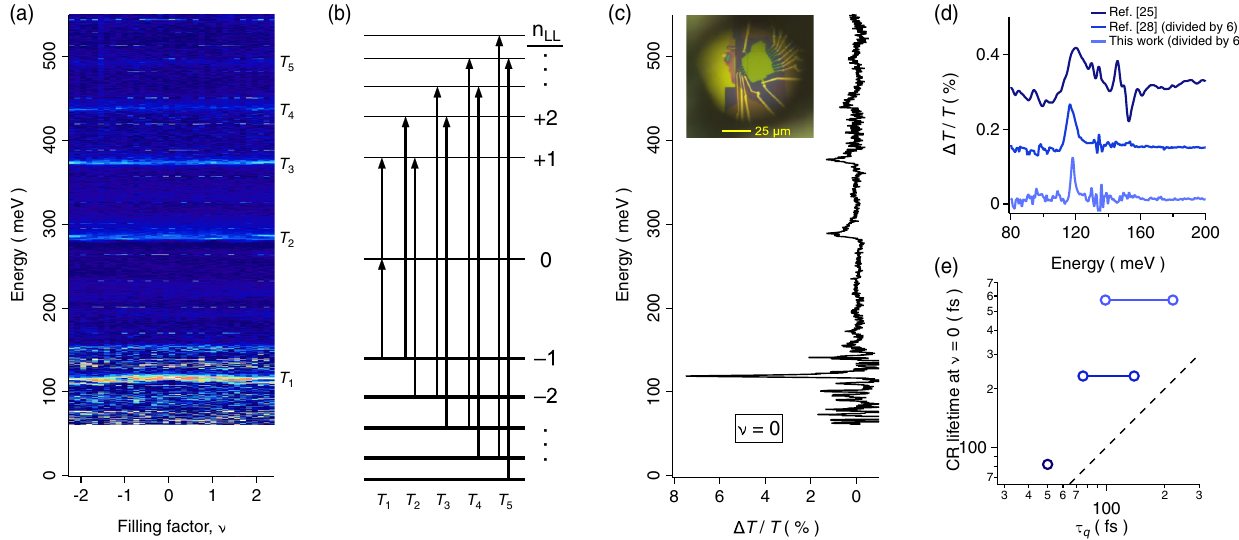
FIG. 1. Cyclotron resonance transitions in graphite-gated monolayer graphene at B ¼ 8 T. (a) Color map of the normalized transmission spectra Δ T=T in the midinfrared as a function of the LL filling factor ν , measured in the device shown in the inset to panel (c). Several sharp CR transitions are visible, labeled T 1 through T 5 . The higher noise in the region of T 1 is due to the overall lower transmission in the 60 – 150-meV energy range, compared to the other transitions (and below 60 meV, the signal goes to zero) [30]. (b) Schematic showing the allowed Landau-level transitions at ν ¼ 0 , consisting of nominally degenerate pairs. (c) Representative line cut of the color map at ν ¼ 0 . (d) Evolution of CR line shape at ν ¼ 0 with the sample quality: The top trace is from a graphene-on-SiO 2 device with mobility of 17 000 cm 2 = Vs [25], the middle is from a hBN-encapsulated device on SiO 2 [28], and the bottom is the present graphite-gated, hBN-encapsulated device; the latter two have the same mobility, μ ≈ 200 000 cm 2 = Vs. (e) CR lifetime τ ν ¼ 0 ( Γ is the half width at half maximum) vs a spread of quantum scattering times τ acquired for a range of carrier densities at 3 K [colors correspond to traces (d)] [30]. The dashed line marks τ